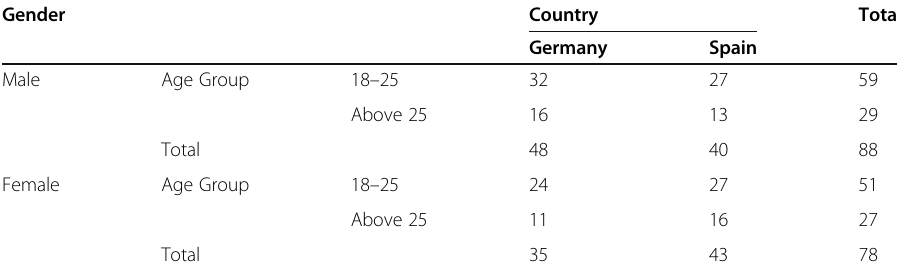
Table 1 Age versus gender characteristics of the participants